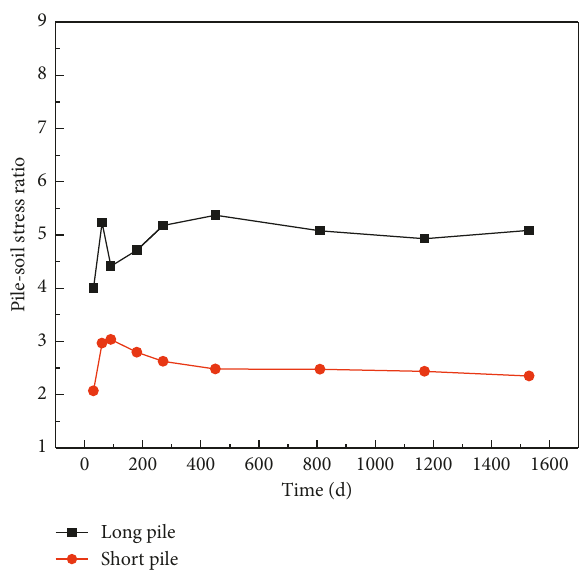
Figure 9: Curves of pile-soil stress ratio change with